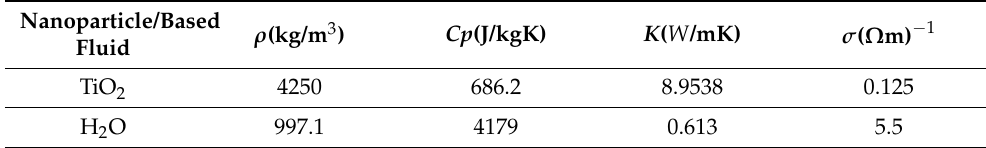
Table 1. Properties (Thermo-physical) regarding H 2 O and TiO 2